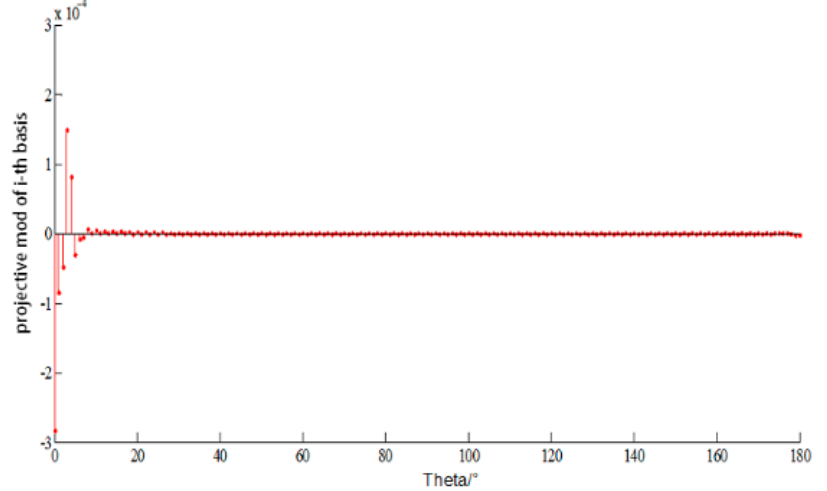
Figure 3. The projection value of the original current of PEC cube based on DCT basis.